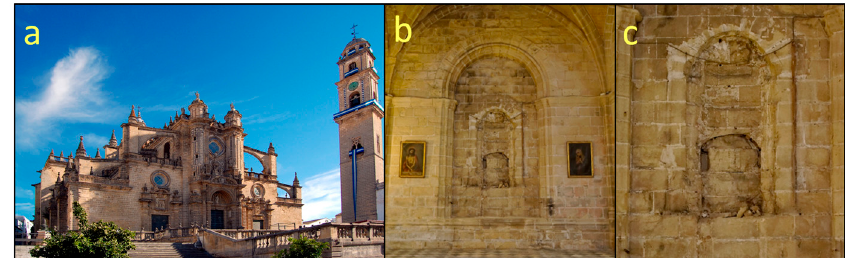
Figure 2. ( a ) View of the main facade of the Cathedral of Jerez de la Frontera. ( b ) Stone altarpiece of the Cathedral from which samples were obtained. ( c ) Detail of the stone altarpiece affected by efflorescence, superficial detachments and sand disaggregation.